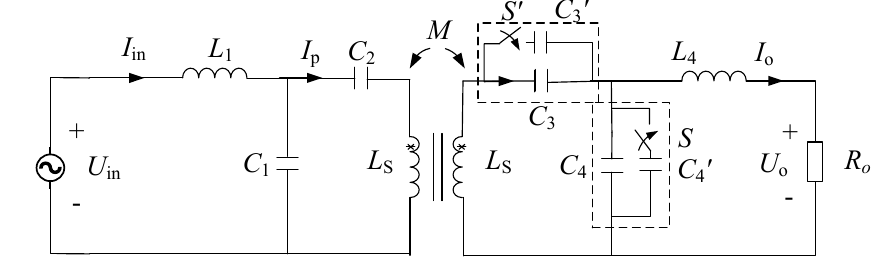
Table 3. Theoretically calculated parameter values of second method.